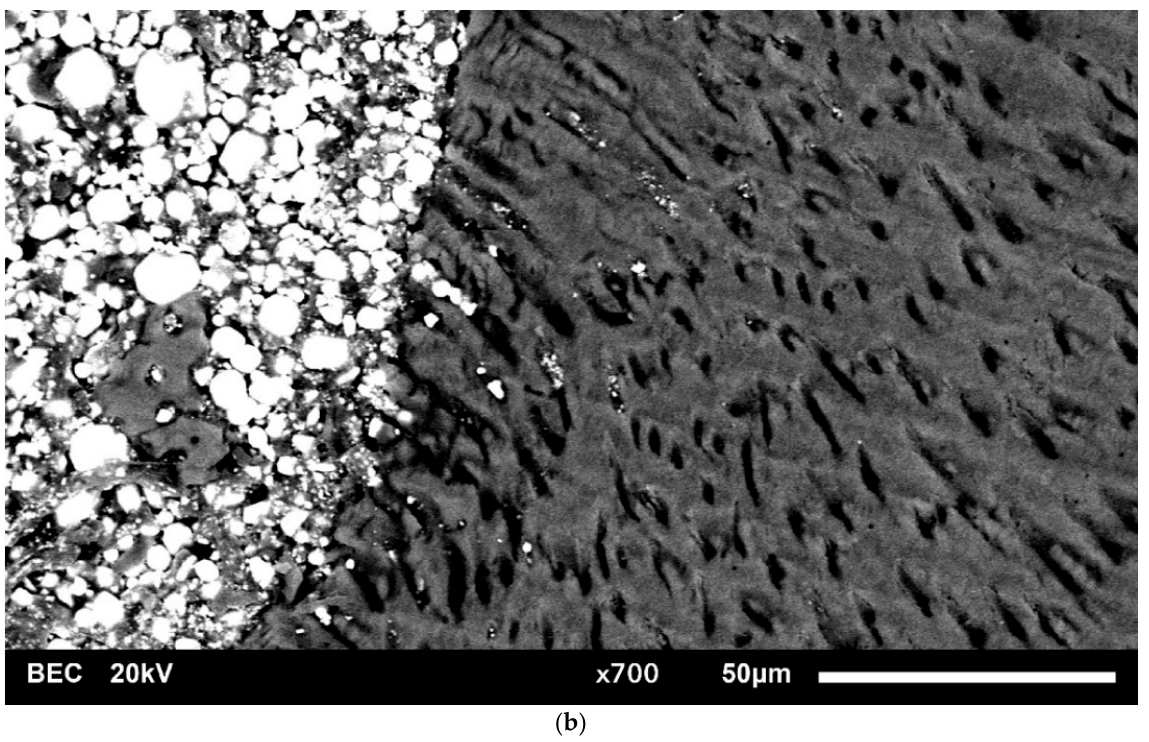
Figure 4. High magnification SEM images (×700) of the sealer-dentin-interface. ( a ) showing low extent of TFHF penetration into dentinal tubules and ( b ) showing low extent of AH Plus penetration into dentinal tubules.